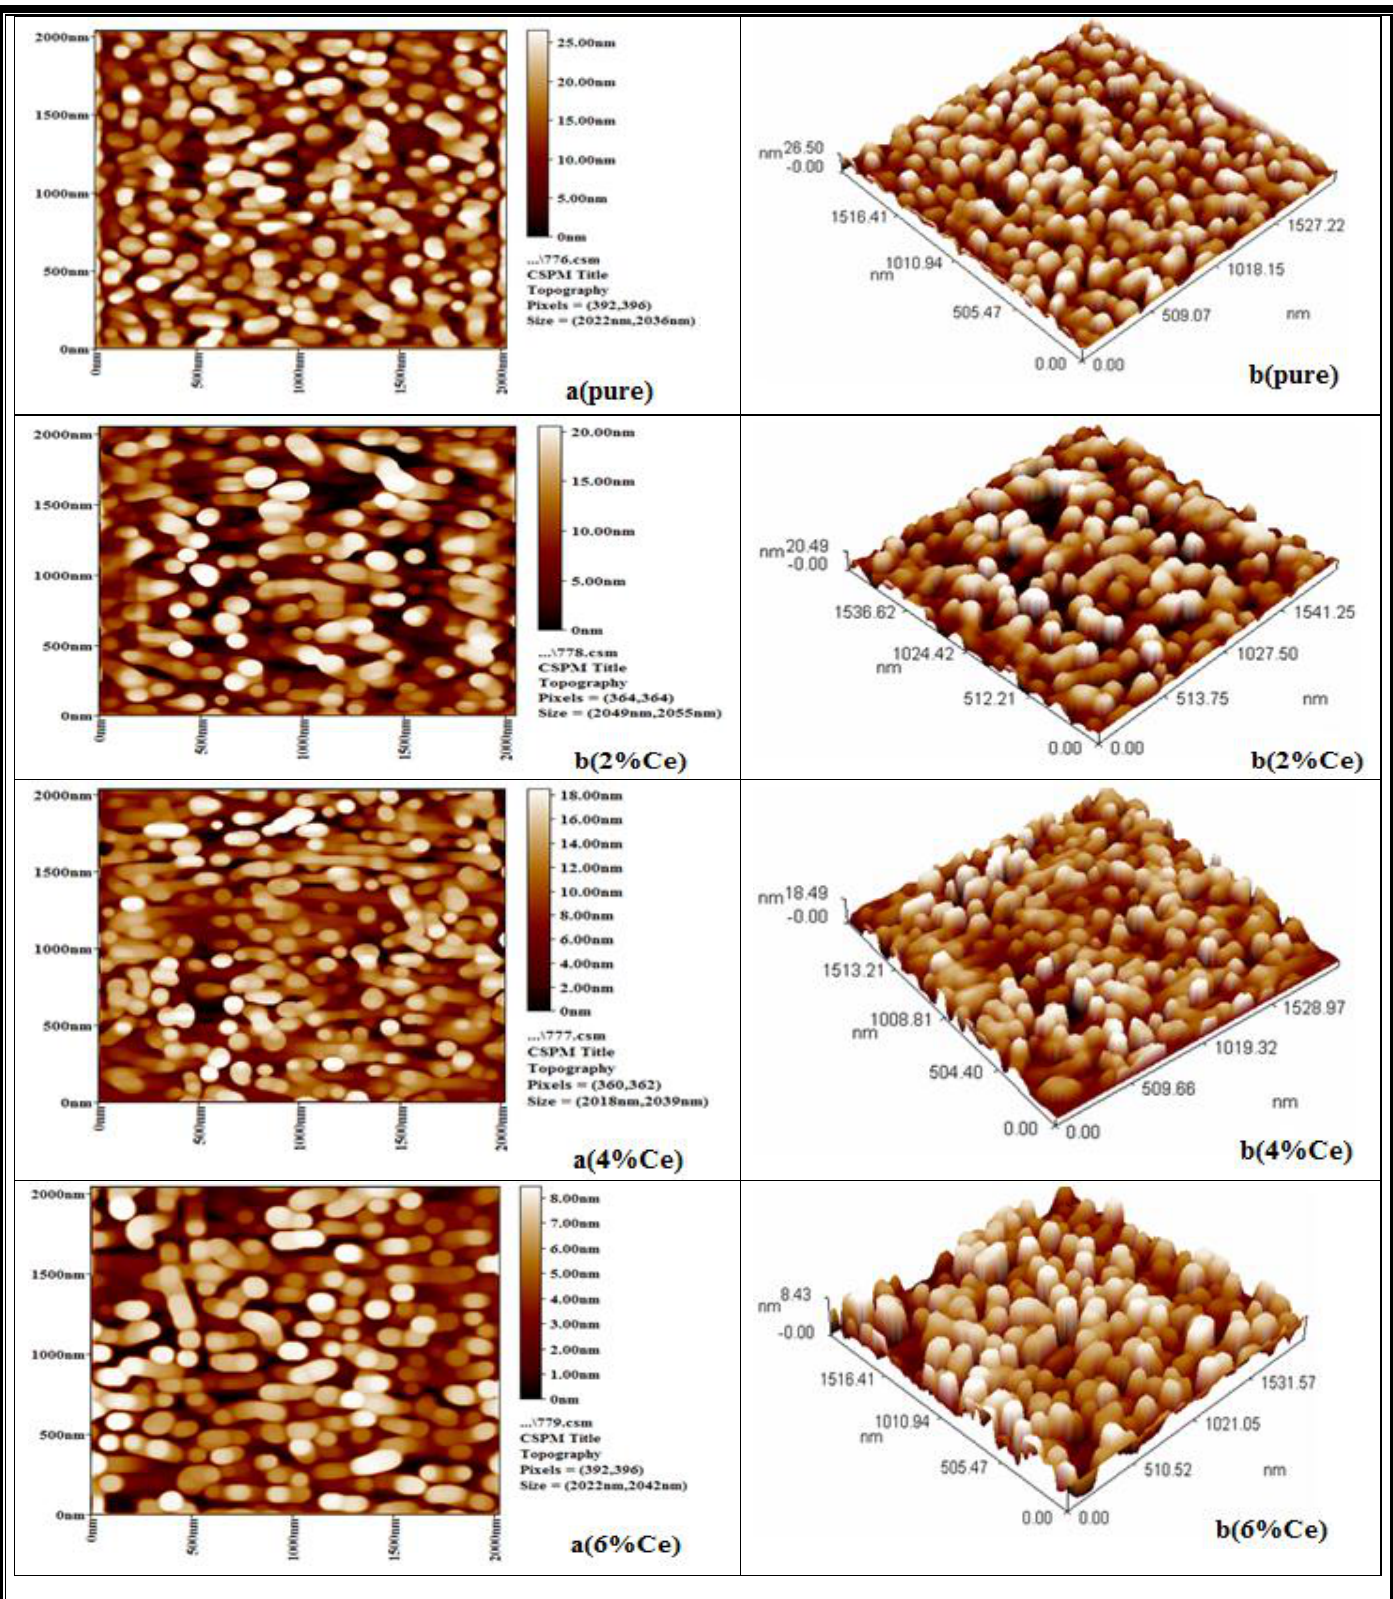
Fig. 4: AFM images (a) 2-D and (b) 3-D of prepared CdO films for on silicon substrates at different concentration of